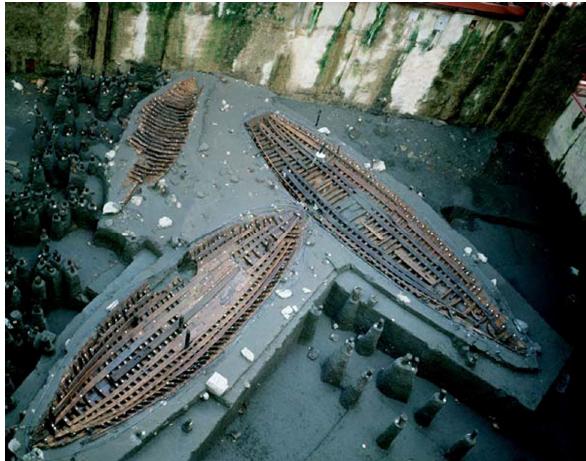
Figure 1: archaeological excavations of ancient Greek